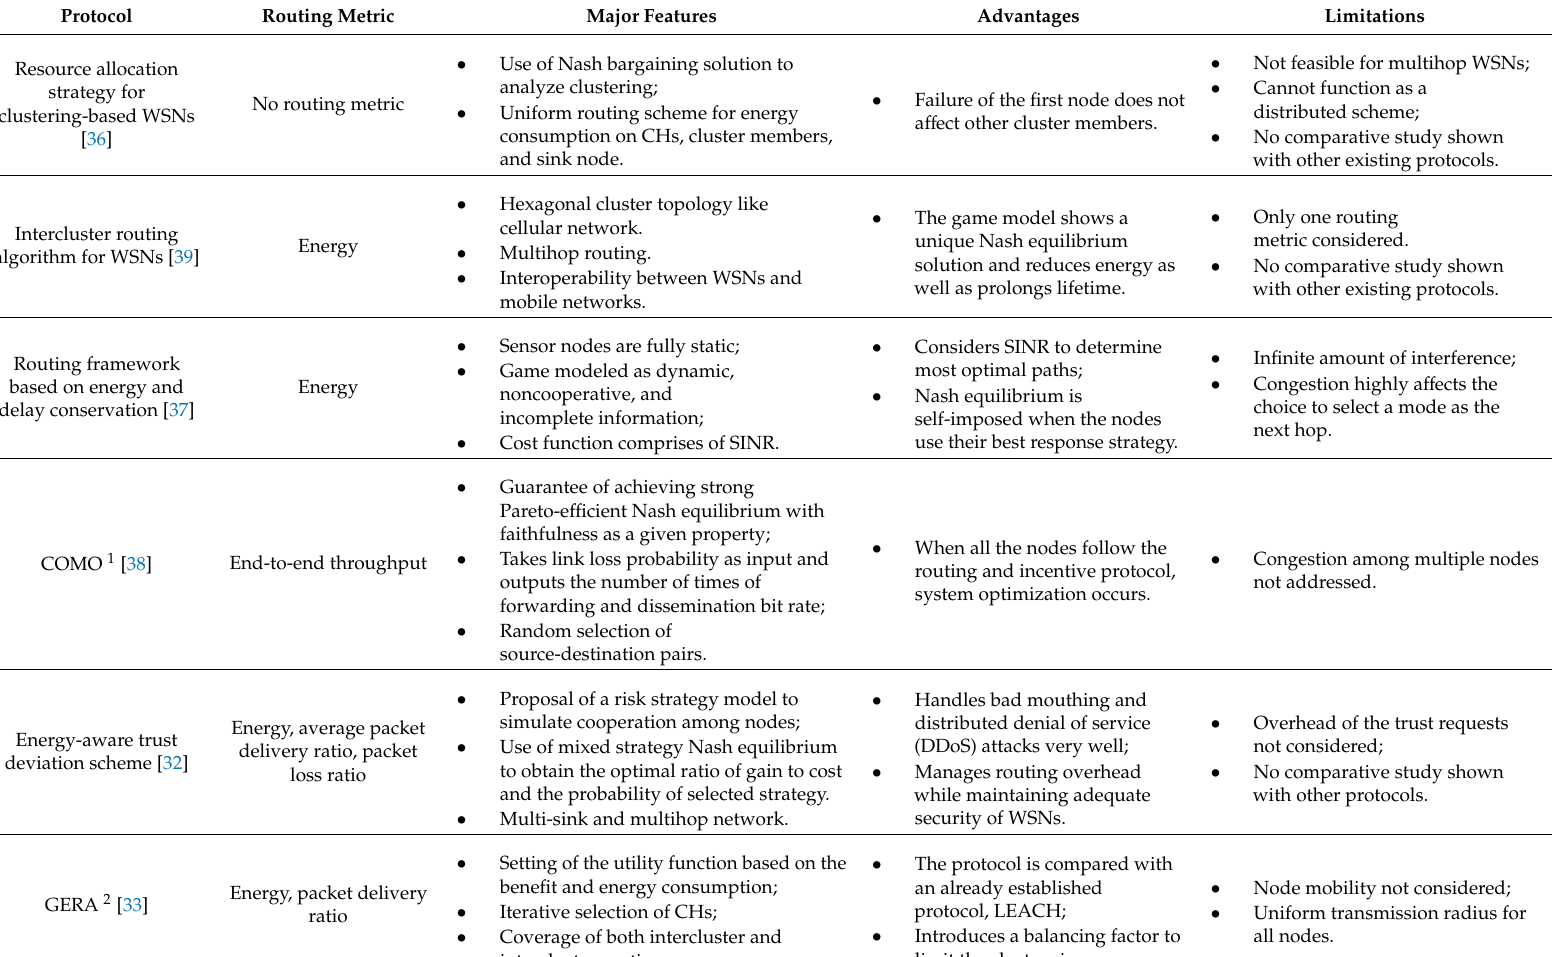
Table 8. Comparison of routing protocols based on noncooperative